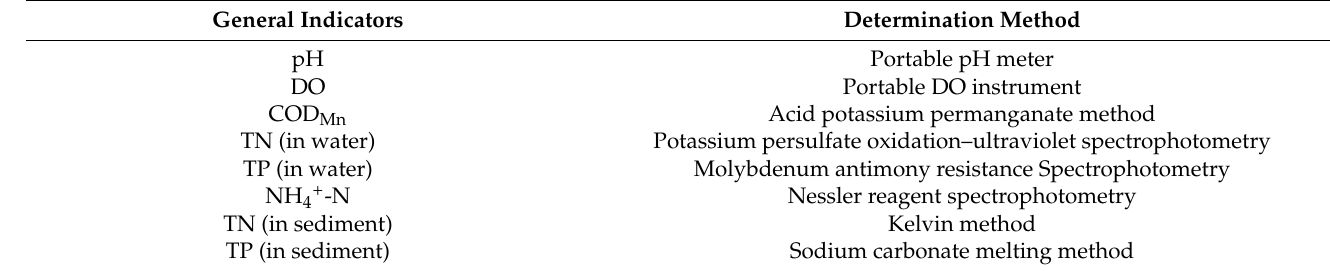
Table 1. Determination Methods of conventional indexes in water and sediments [28,29]. General